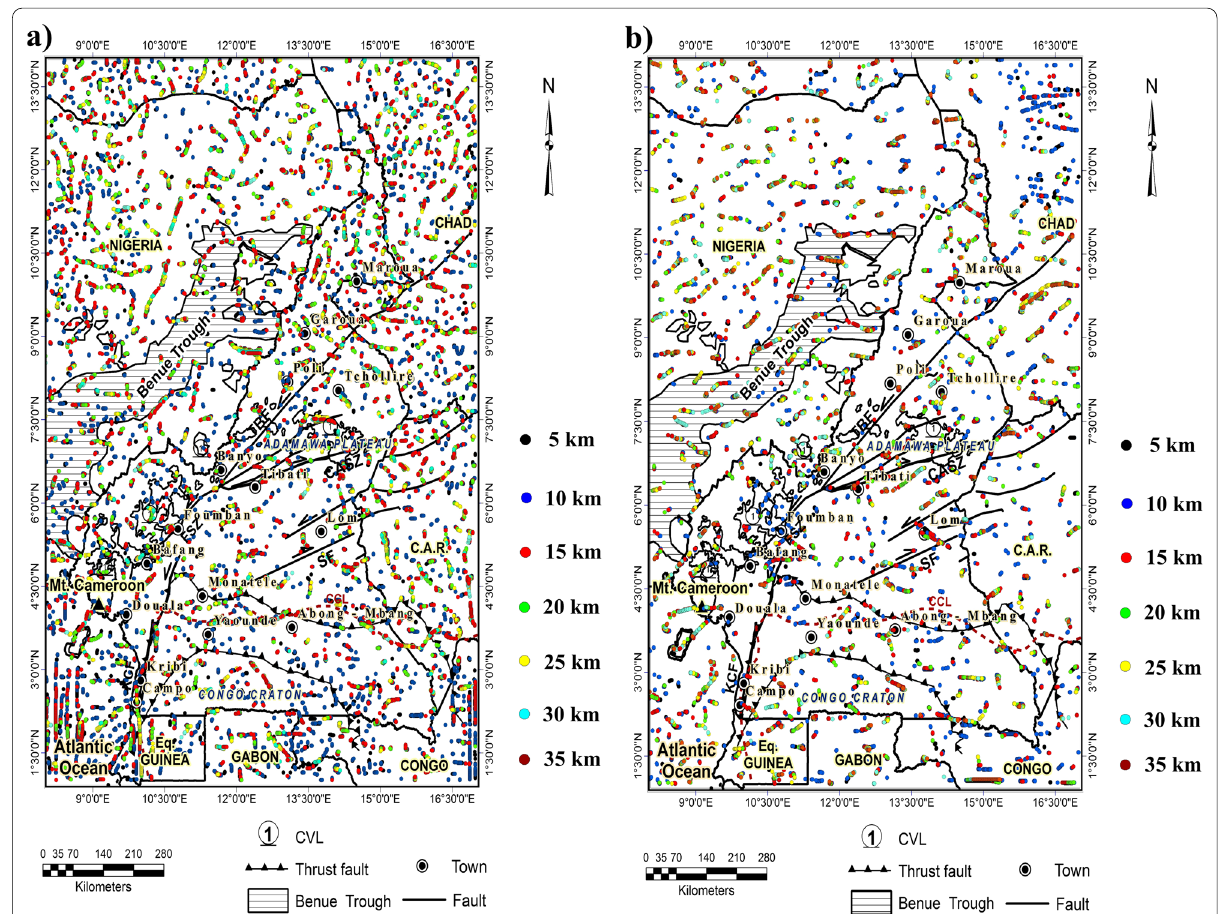
Fig. 7 Map of horizontal gradient maxima derived from upward continuation at different heights: a using Bouguer anomalies and b